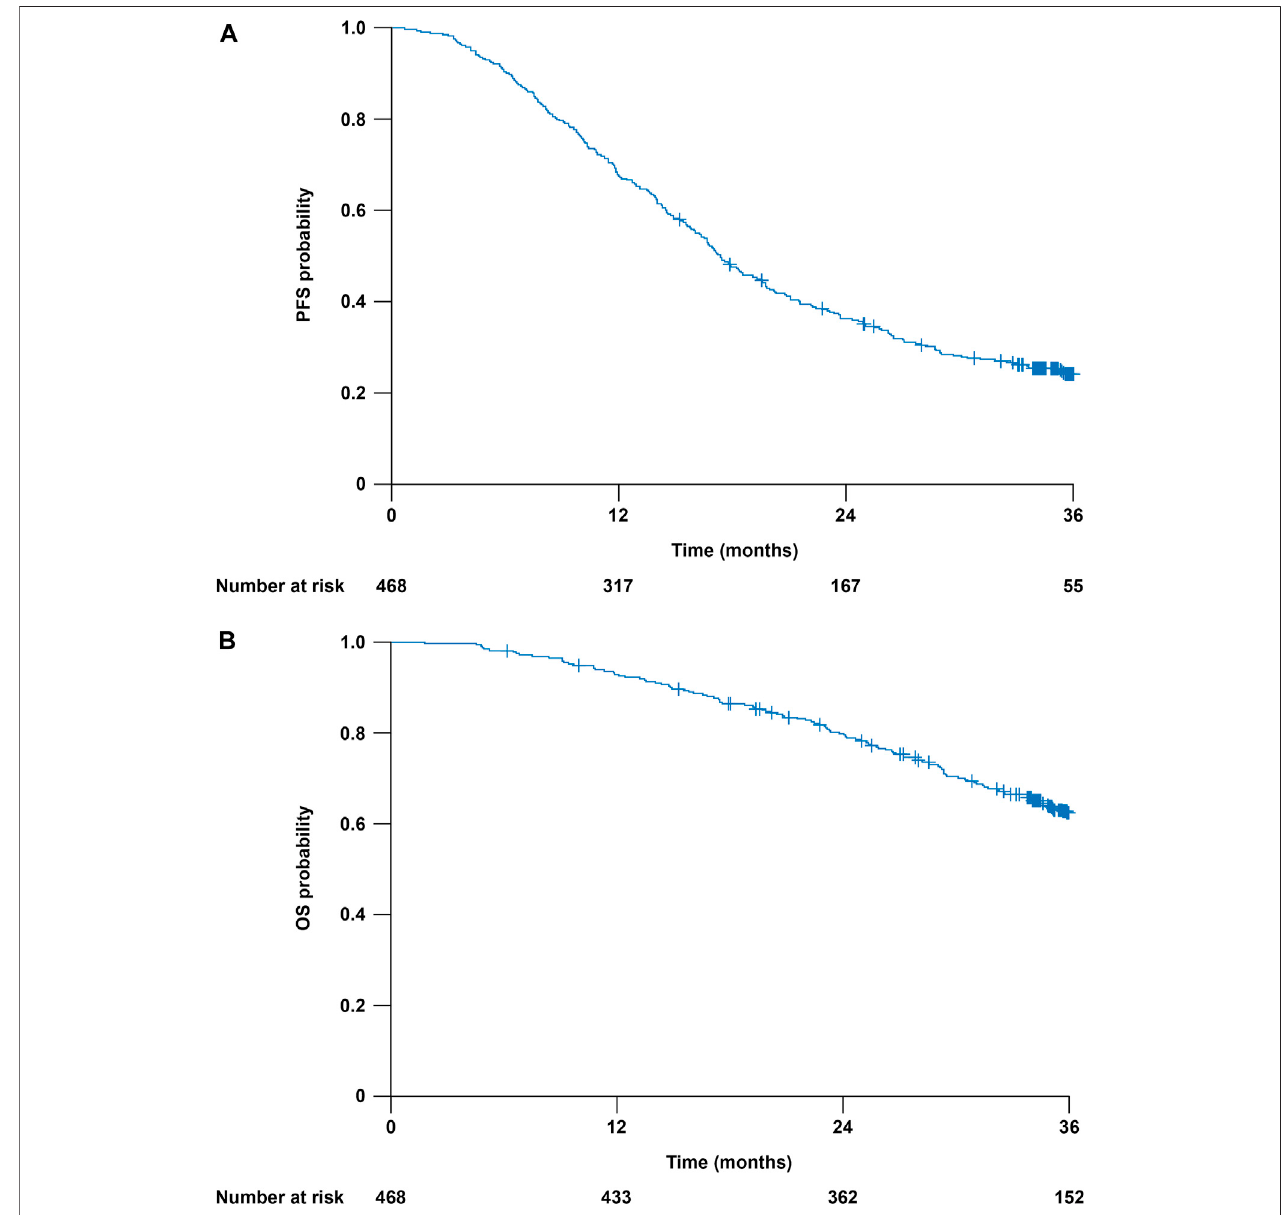
FIGURE 3 | Clinical outcomes in the 468 analyzed patients. Kaplan-Meier curves are truncated at 36 months. (A) Progression-free survival (PFS). (B) Overall survival (OS).